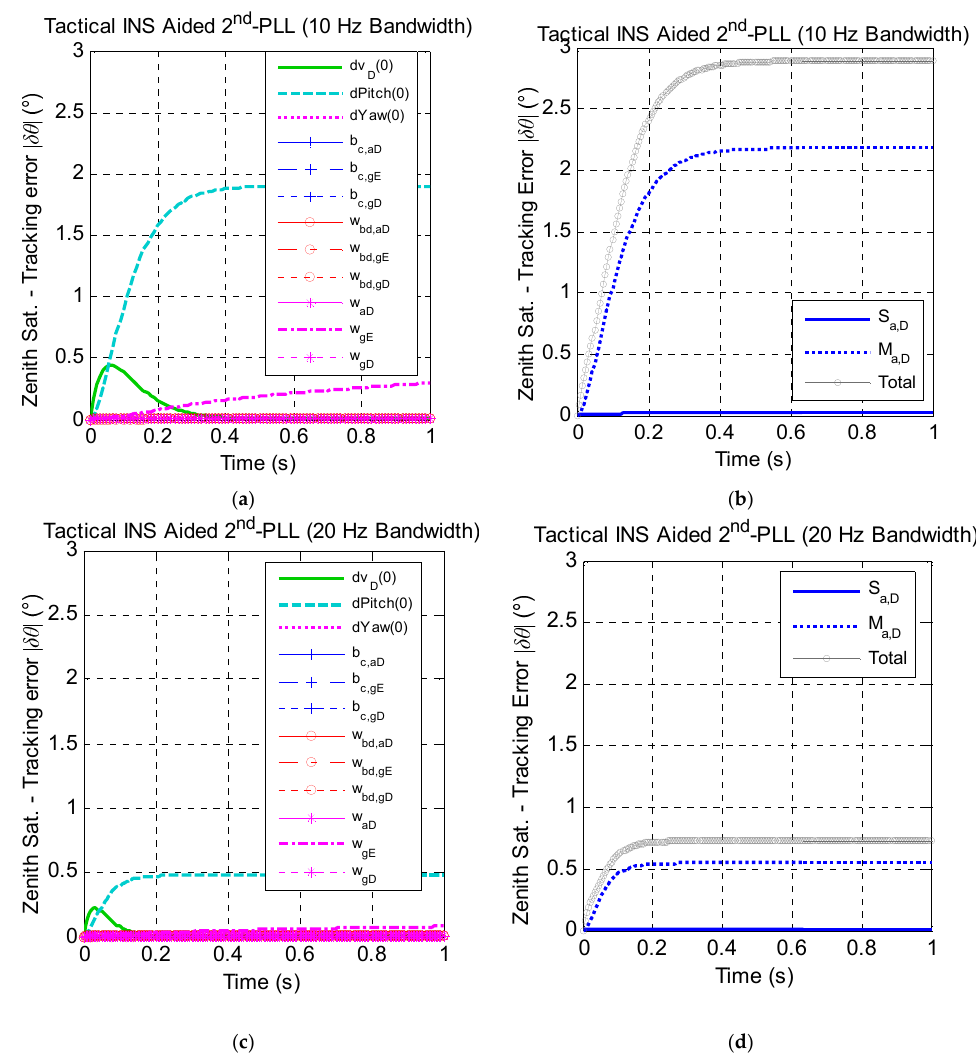
Figure 10. The zenith satellite tracking error caused by tactical INS error sources under the assumption of linear high dynamics along the north direction. ( a ) Effect of non-maneuver-dependent error with a 10-Hz bandwidth; ( b ) effect of maneuver-dependent error with a 10-Hz bandwidth; ( c ) effect of non-maneuver-dependent error with a 20-Hz bandwidth; ( d ) effect of maneuver-dependent error with a 20-Hz bandwidth. (* Here, Sat. is the abbreviation of satellite.) Based on the principles mentioned above, quantitative analysis of the carrier phase tracking errors caused by INS error sources including satellites from different directions (i.e., north, east and zenith) can be achieved by assuming that the vehicle is in uniform high dynamic linear acceleration motion along the east direction (i.e.,